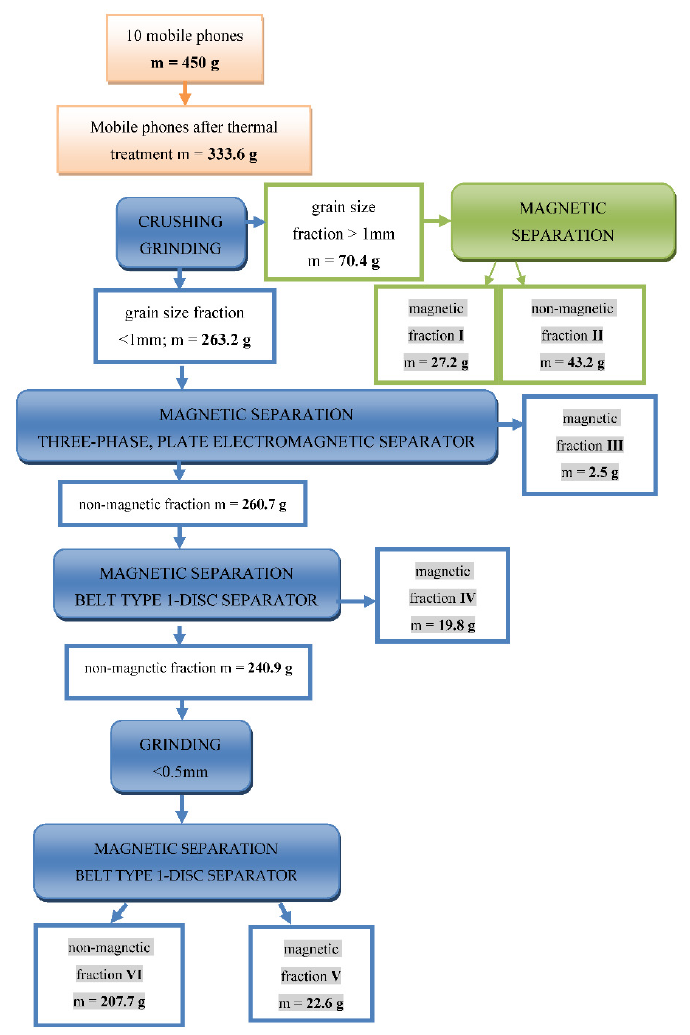
Figure 2. The scheme of the magnetic enrichment process of solid products after the combustion of used mobile phones.